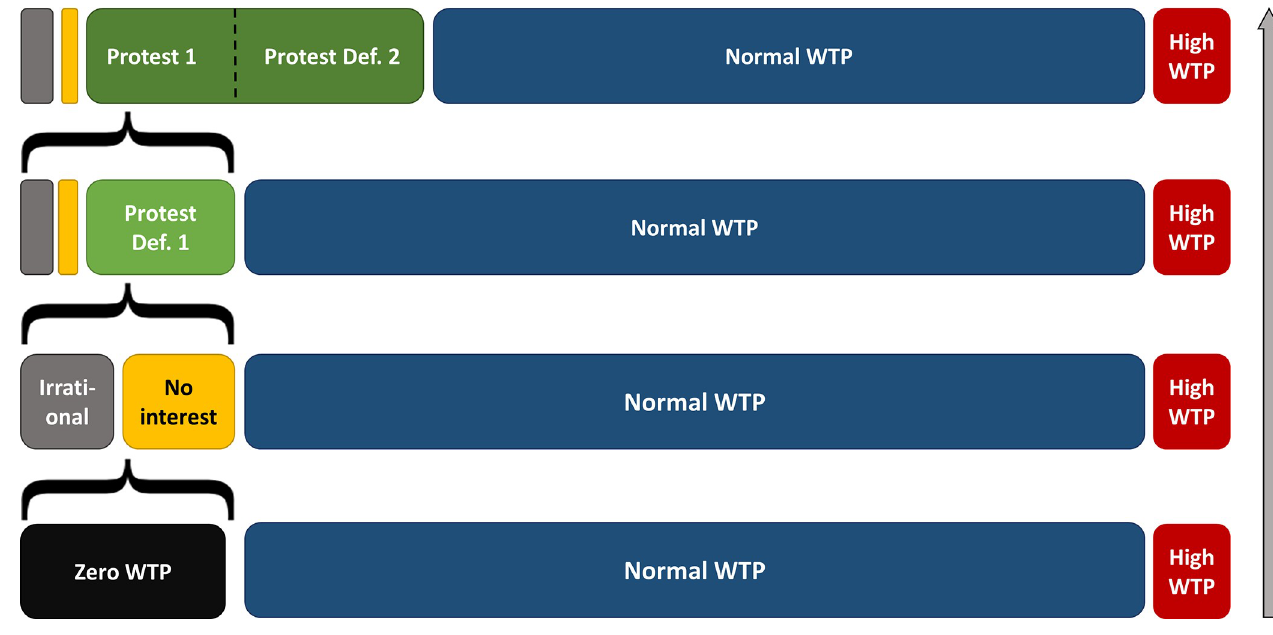
Fig 1. Conceptualization of WTP-answers.